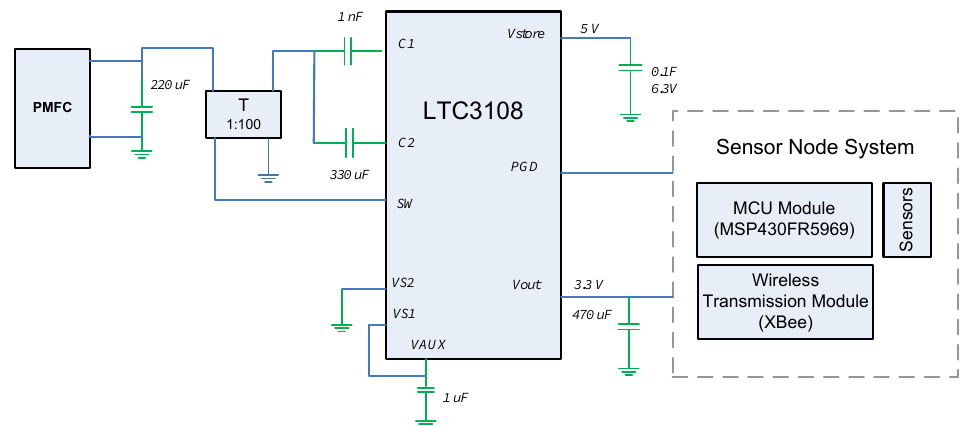
Figure 3. EH subsystem based on LTC3108 power management